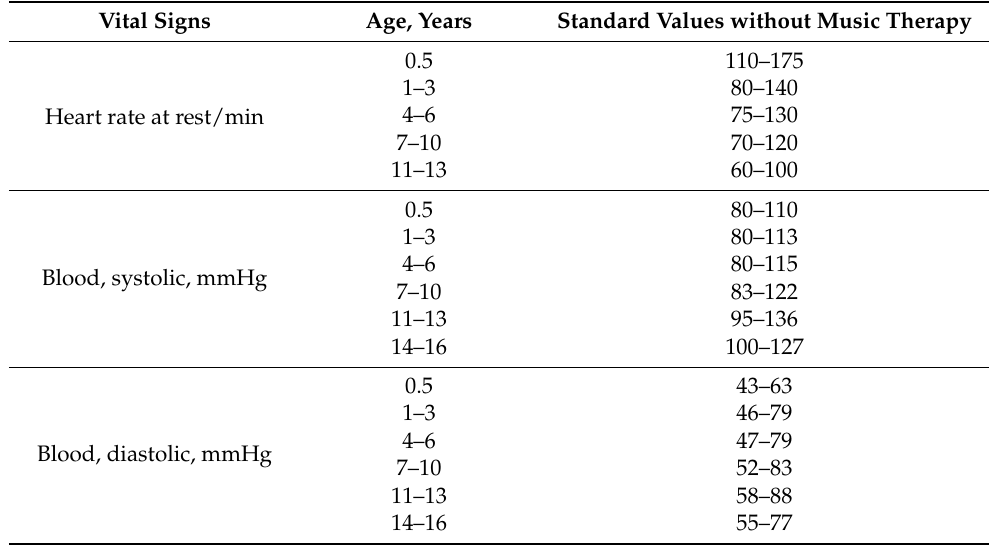
Table 3. Standard values in heart rates and systolic and diastolic blood pressure. Vital Signs Age, Years